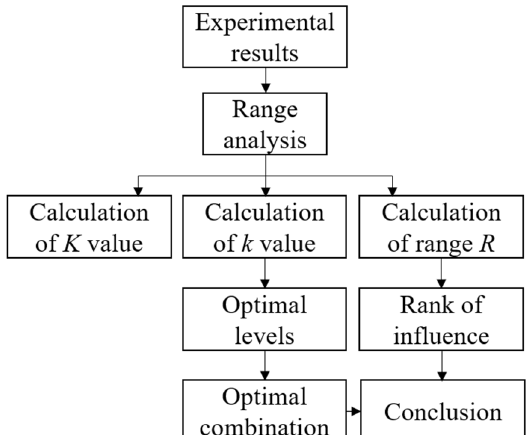
Figure 6. Flowchart for analyzing experimental results.